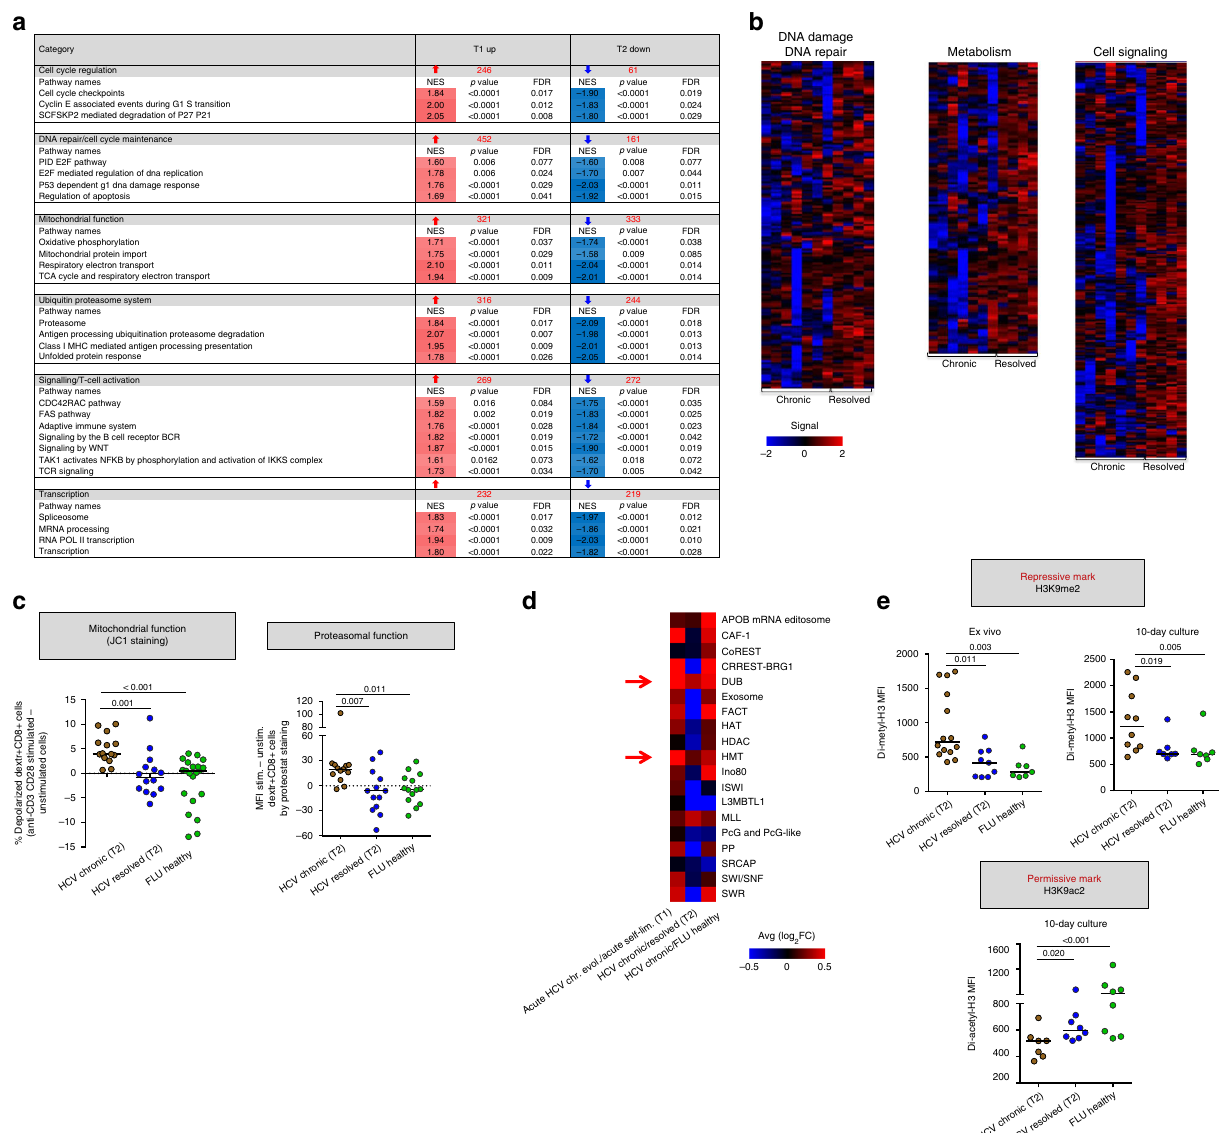
Fig. 6 Epigenetic transcriptional repression in exhausted HCV speci fi c CD8 + T cells from chronic patients. a Six distinct functional groups of pathways enriched in upregulated genes (red) in T1/early and displaying the opposite trend (blue) in T2/late identi fi ed by GSEA (MSigDB, C2 canonical pathways and C5 Gene Ontology sets) in HCV-speci fi c CD8 + T cells from chronically evolving patients. NES = normalized enrichment score; FDR = False Discovery Rate. In red, above the p -value columns, is shown the total number of genes signi fi cantly upregulated in T1/early and downregulated in T2/late in each group of pathways. b Heat-maps comparing the expression pro fi les of leading genes belonging to the DNA repair/damage response, metabolism and cell signaling pathways in chronic and resolved infections (see also the T2 sheets in Supplementary Data 2). c Mitochondrial (left panel, JC-1 staining) and proteasomal (right panel, ProteoStat staining) functions were assessed in dextramer-stained HCV-speci fi c CD8 + T cells from T2/late chronic and T2/late self-limited HCV infection and in healthy controls following PBMC overnight stimulation with anti-CD3/CD28. MFI, Median Fluorescence Intensity. d Heat- map comparing the expression levels (average log 2 fold change) of epigenetic regulatory complexes (derived from the EpiFactors database as detailed in Methods section) in chronic vs. self-limited infection (T1/early), chronic vs. resolved infection (T2/late) and chronic (T2/late) vs. healthy controls. e Repressive H3K9me2 (upper panels) and permissive H3K9ac2 (lower panel) histone marks determined by fl ow cytometry in dextramer-stained HCV speci fi c CD8 + T cells from T2/late chronic and T2/late resolved HCV patients or healthy controls. PBMC were stimulated overnight with anti-CD3/CD28 (ex vivo staining) or for 10 days with HLA-A2-restricted HCV-speci fi c or FLU-speci fi c peptides. Horizontal lines in panels c and e represent median values. Differences between multiple groups in panels c and e were evaluated with the non-parametric Kruskal-Wallis test; p -values were corrected for pairwise multiple comparisons with the Dunn ’ s